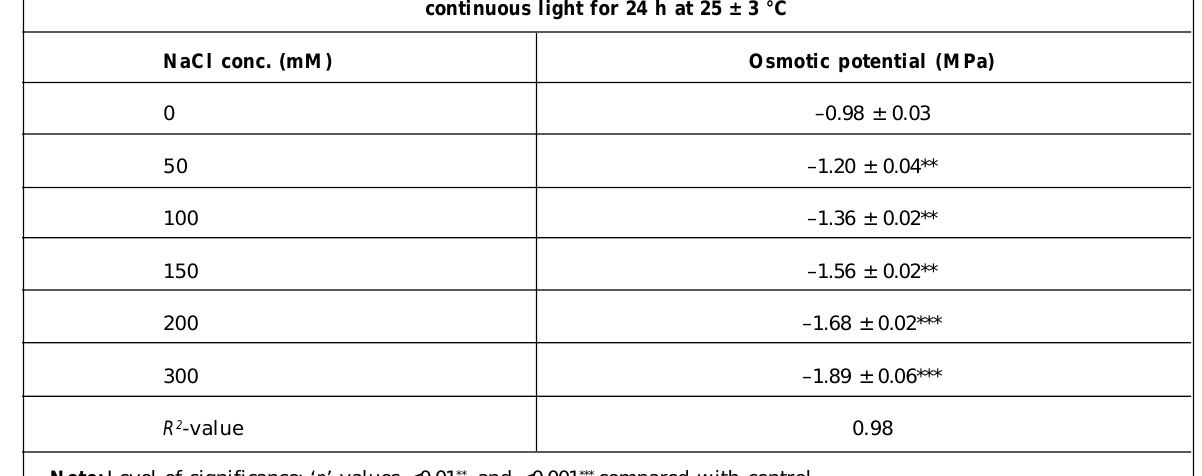
Table 1: Effect of salt stress imposed by using NaCl on osmotic potential in etiolated maize leaf segments during greening Leaf segments from dark grown maize seedlings were treated with varying concentrations of NaCl in continuous light for 24 h at 25 ± 3 °C